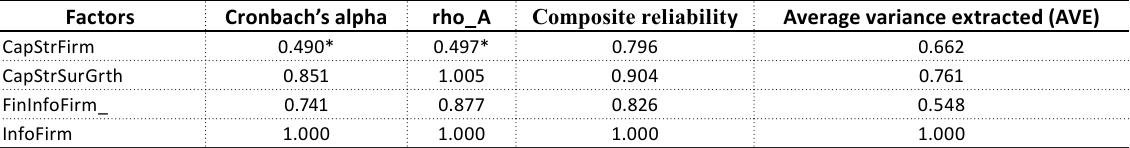
Table 1. Construct reliability and